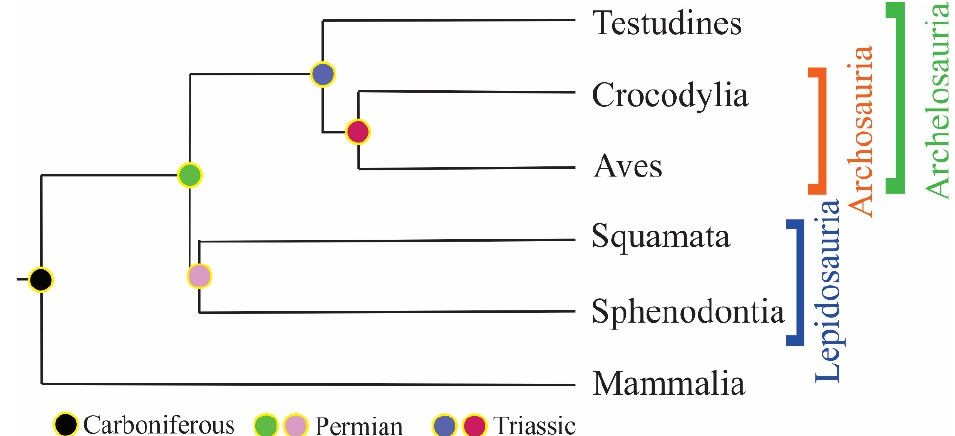
Figure 1. Evolutionary tree of amniotes (adapted from Ref. [5]. 2009, Shedlock, A.M., et al.).